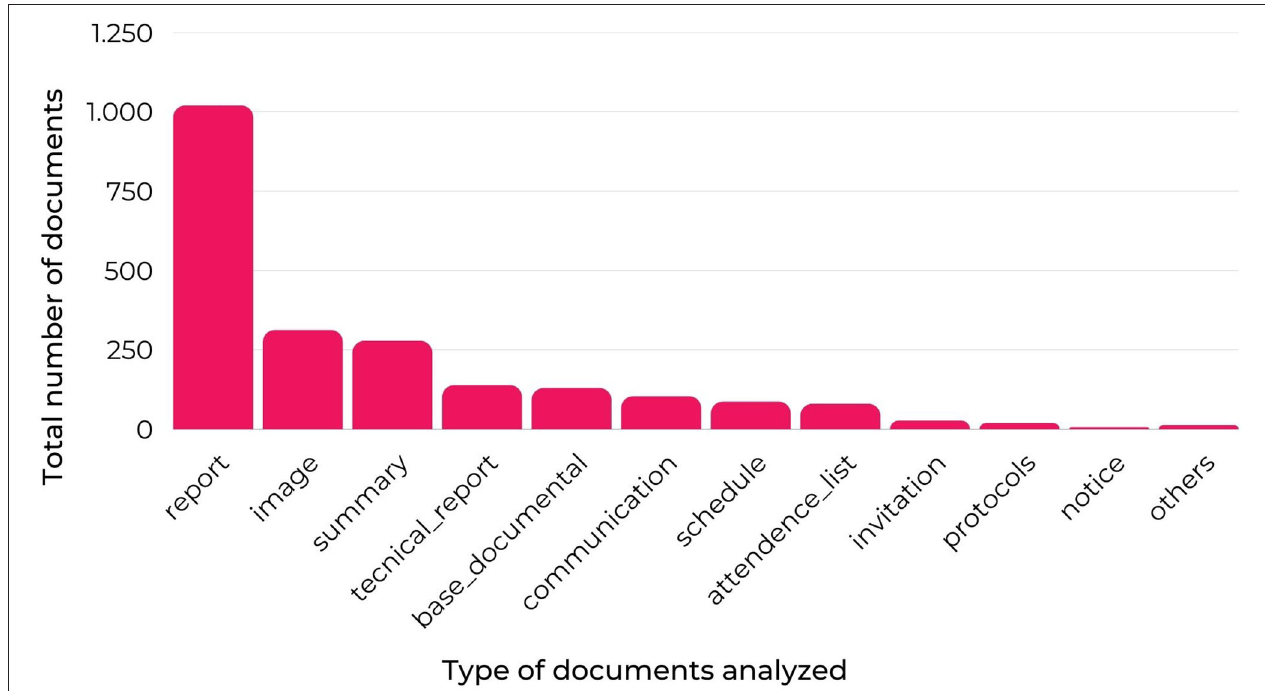
FIGURE 2 | Types of files in the “LUES Platform”.